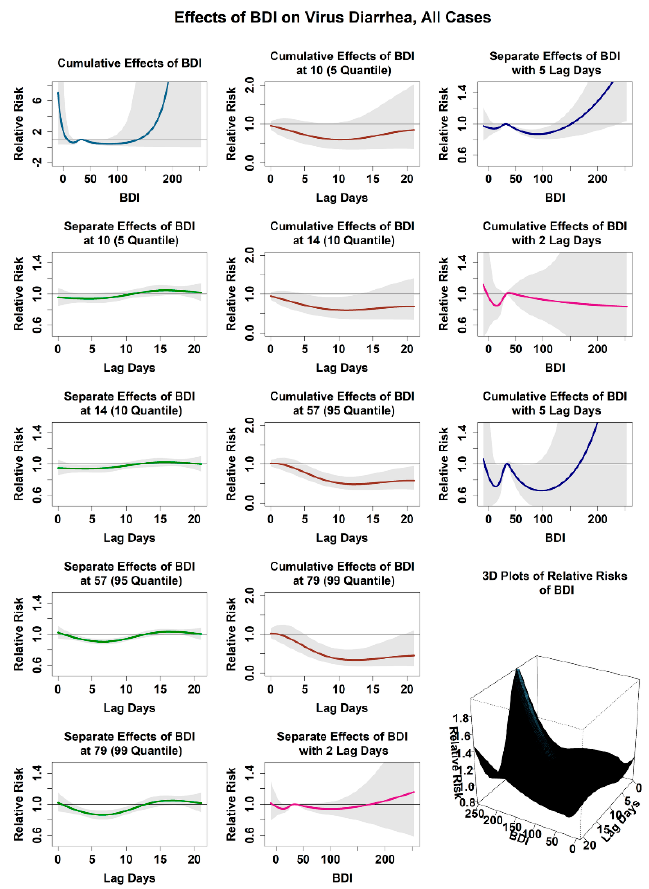
Figure 5. Effect of combined Baidu index on virus diarrhea in Jilin Province, all cases.